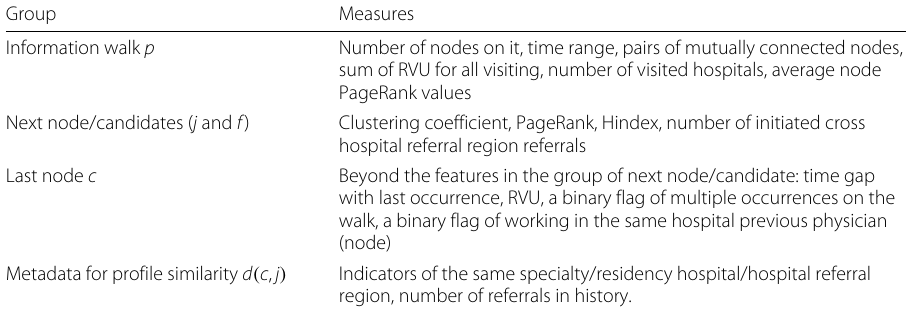
Table 3 Features about information walks and related nodes including applicable network measures, new metrics defined by our past analysis (An et al. 2018a), and a few from the metadata of medical treatment records, such as Relative Value Units (RVU) of medical